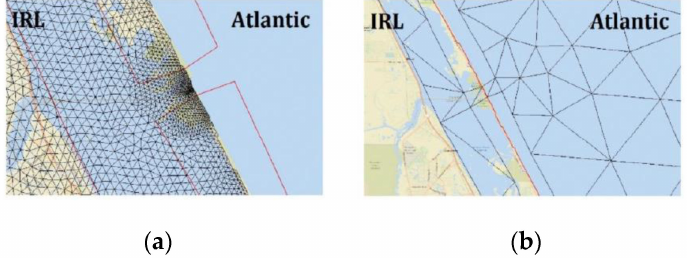
Figure 4. Grid scale comparison between high-resolution domain ( a ) and parent coarse domain ( b ) [28]. Red lines indicate elemental boundaries of the opposing domain mesh.